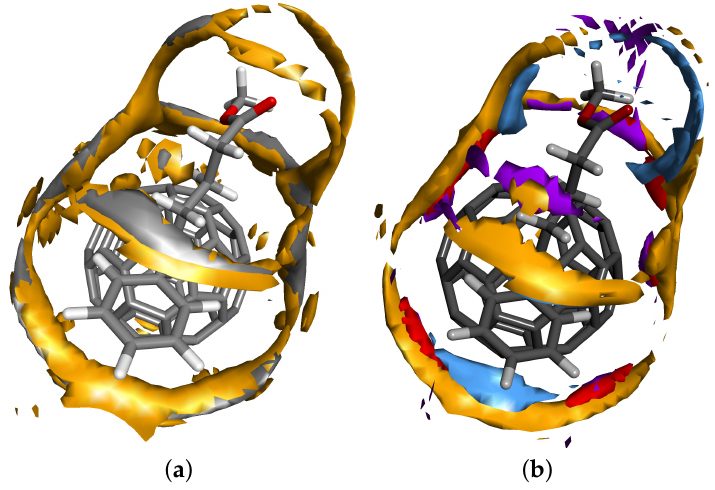
Figure 5. 3D solvation structure around the PCBM molecule in P3HT ( a ) and P3BT ( b ), respectively, at T = 400 K, obtained with the use of the 3D-RISM-KH theory. Different colour isosurfaces around the PCBM molecule correspond to the probability of finding different interaction sites belonging to P3HT or P3BT, respectively. Only high values of the first solvation shell are shown. We use the following colours: dark yellow, sulphur of P3HT or P3BT; grey, carbon at the end of the hydrocarbon tail of P3HT; red, oxygen in the OH group of P3BT; purple, oxygen of P3BT; blue, hydrogen in the OH group of P3BT. The 3D distribution of interaction sites demonstrates preferential mutual orientation of solute and solvent molecules in solution and defines the morphology of the system on the